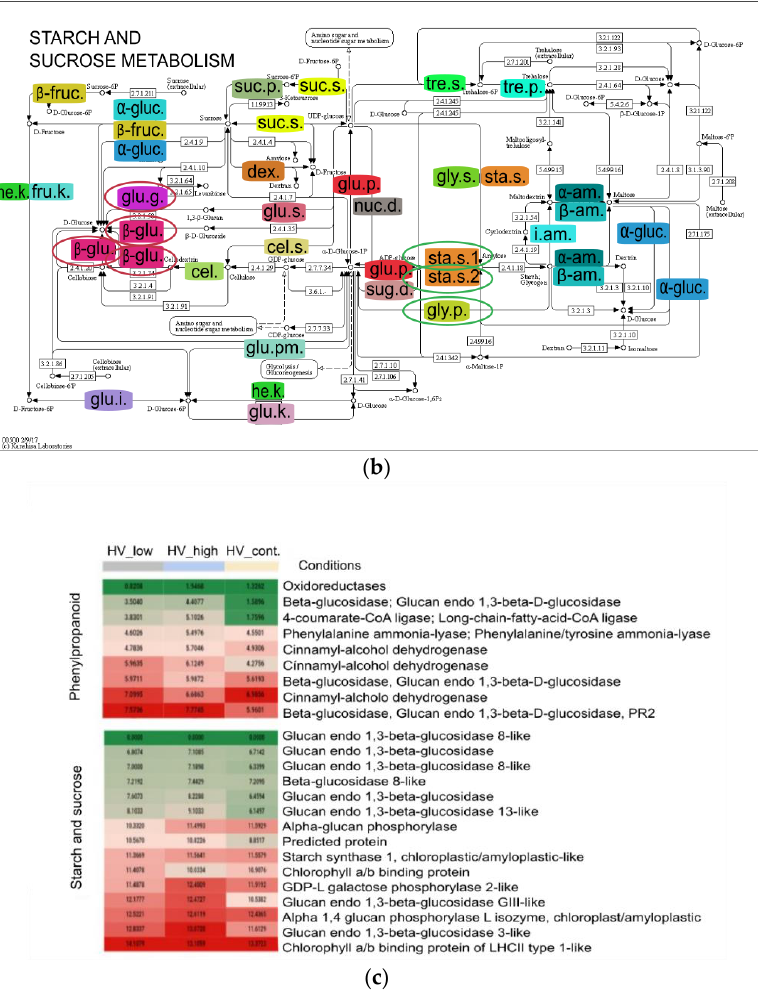
Figure 8. ( a ) Phenylpropanoid and ( b ) starch and sucrose biosynthetic pathways with DEGs. In this KEGG pathway analysis, 73 and 142 contigs were aligned; among them, 9 and 5 showed differentiated expressions that are functionally identified, respectively. Colored enzyme codes mean mapped contigs to the pathways that were found in samples treated by ELICE16INDURES (low and high dosage). ( c ) Heat map highlights the up- and downregulated genes found in these pathways circled with red and green in KEGG-maps. Abbreviations of phenylpropanoid pathway: phenylalanine ammonia-lyase (PAL), phenylalanine/tyrosine ammonia-lyase (PTAL), trans-cinnamate 4-monooxygenase (CYP), 4-coumarate–CoA ligase (4CL), cinnamoyl-CoA reductase (CCR), cinnamyl-alcohol dehydrogenase (CAD), beta-glucosidase ( β -gluc.), sinapate 1-glucosyltransferase (glu.tr.) and peroxidase (perox.) Abbreviations of starch and sucrose metabolism: beta-fructofuranosidase ( β -fruc.), alpha-glucosidase ( α -glu.), sucrose alpha-glucosidase, hexokinase (he.k.), fructokinase (fru.k.), glucokinase (glu.k.), glucose-6-phosphate isomerase (glu.i.), glucose phosphomutase (glu.pm.), glycogen phosphorylase (gly.p.), ADP-sugar diphosphatase (sug.d.), glucose pyrophosphorylase (glu.p.), starch synthase (sta.s.), cellulose synthase (cel.s.), 3 beta-glucan synthase (glu.s.), cellulose (cel.), beta-glucosidase ( β -glu.), glucan endo-1,3-beta-D-glucosidase (glu.g.), dextransucrase (dex.), sucrose synthase (suc.s.), sucrose-phosphate phosphatase (suc.p.), trehalose phosphate synthase (tre.s.), trehalose-phosphatase (tre.p.), nucleotide diphosphatase (nuc.d.), UDP-glycogen synthase (gly.s.), alpha-amylase ( α -am.), beta-amylase ( β -am.) and isoamylase